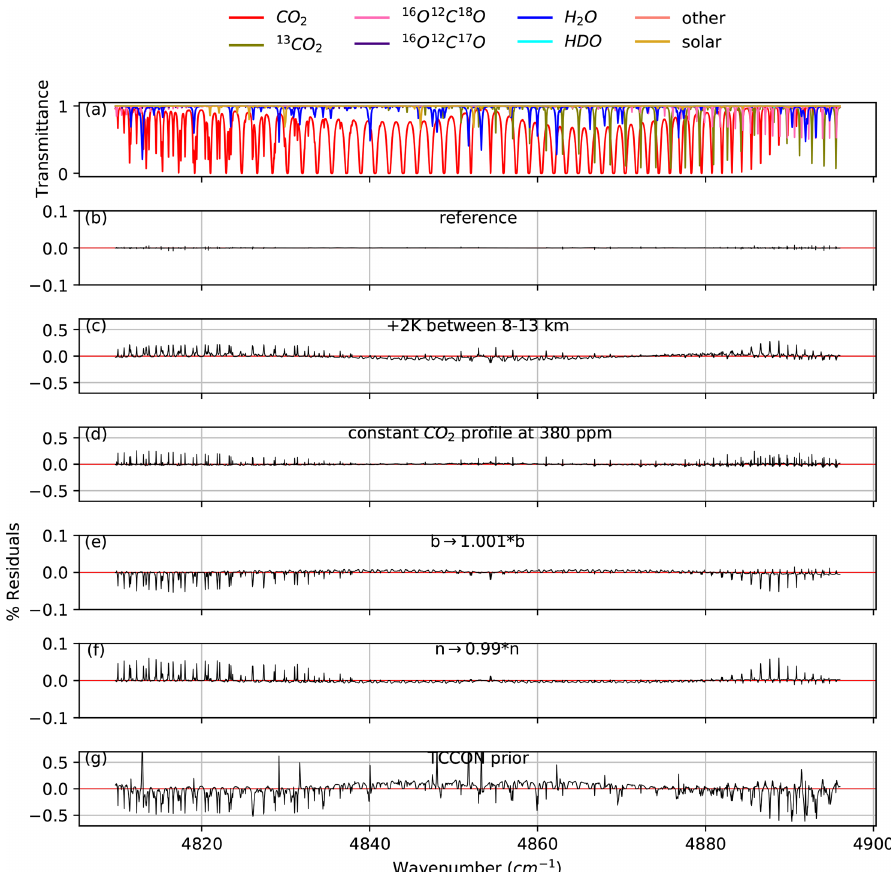
Figure 8. Panel (a) shows an example of calculated lines in the Strong CO 2 window. The other panels show residuals from fits to a synthetic spectrum, using the same inputs used to generate the synthetic spectrum except for (b) no perturbation; (c) + 2 ◦ C perturbation to the a priori temperature between 8 and 13km; (d) a CO 2 prior profile set to 380ppm at all levels, corresponding to ∼ 15ppm offset from the unperturbed prior; (e) air- and self-broadened Lorentz half-width coefficients increased by 0.1%; (f) temperature dependence of the half-width coefficients decreased by 1%; and (g) using the a priori profiles that would be used by TCCON operational processing, instead of that constructed from in situ measurements, resulting in a combination of different errors in the a priori profiles such as H 2 O, temperature, and CO 2 . Note the vertical scale of panels (b) , (e) , and (f) is 5 times smaller than that of panels (c) , (d) , and (g)